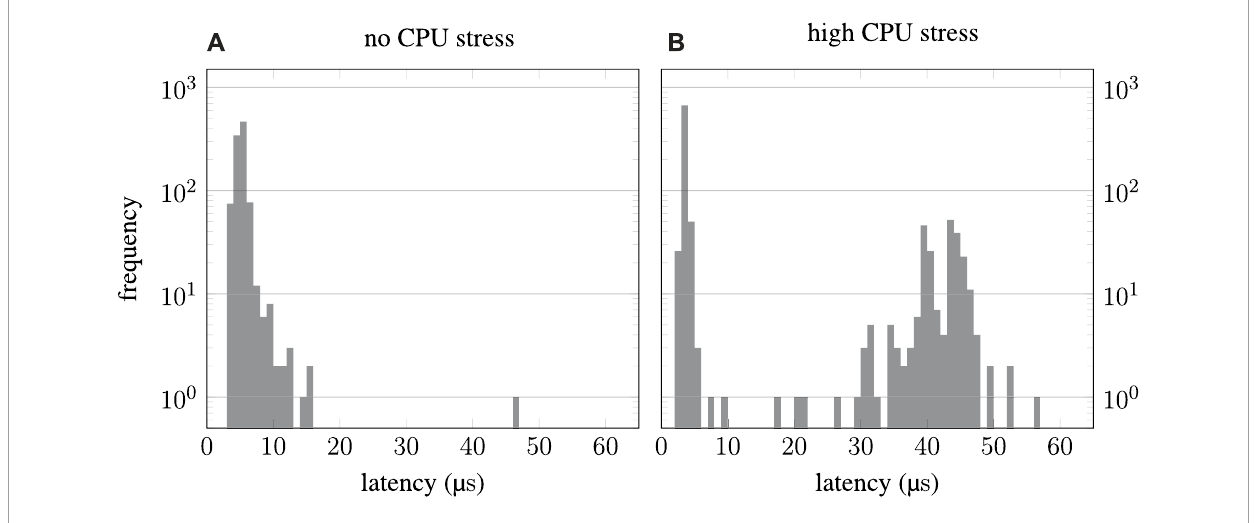
FIGURE 1 ROS 2 “pendulum demo” benchmark results. While the system 1 was only running the “pendulum demo” for the left histogram (A) , additional stress was put on the CPU for the right-hand results (B) . Although the results presented by Kay and Tsouroukdissian (2015) are reproduced very well, logarithmic scaling of the frequency axis reveals a significant number of samples with high